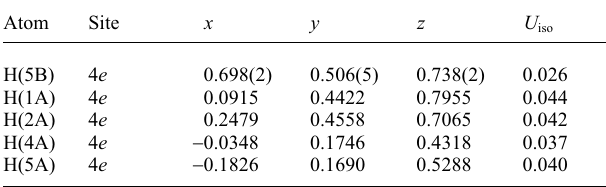
Table 2. Atomic coordinates and displacement parameters (in Å 2 ) .